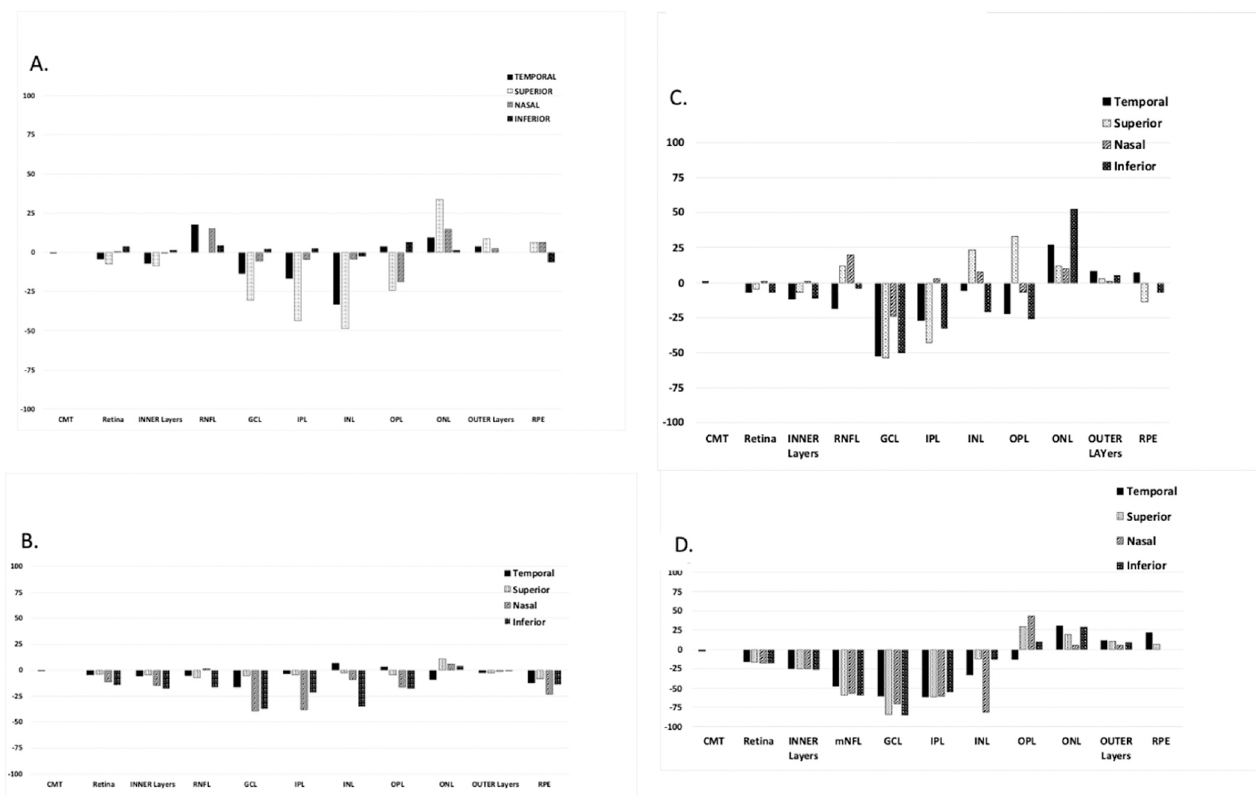
Fig 3. Retinal layer thickness changes in BRAO and CRAO patients. (A) Left eye after 28 days from a 69-year-old male patient with BRAO and hypertensive retinopathy OU and VA of 20/30. The most affected GCL thickness decrease was observed in the superior, inner (-31%) and outer (-45%, not shown) quadrants. (B) Right eye from a 68-year-old male patient 36 days after celio-retinal artery infarct BRAO with a VA of 20/25 V. The most affected GCL thicknesses in the inner ring were in the nasal (—39%) and inferior (-37%) quadrants. (C) Right eye at 23 days from a 66-year-old male patient with BRAO and non-proliferative diabetic retinopathy and VA of 20/20. Probable plaque was observed at the first branch point of the superior arterioles. GCL decrease in the superior inner quadrant was (-54%), and the nasal and temporal were similarly affected. (D) Right eye at 47 days from 67-year-old patient with CRAO, retinal artery-vein “nicking,” and VA in affected eye of 20/200. The pattern of loss of inner retinal layers was similar to BRAO, but is generally more severe with more quadrants involved.